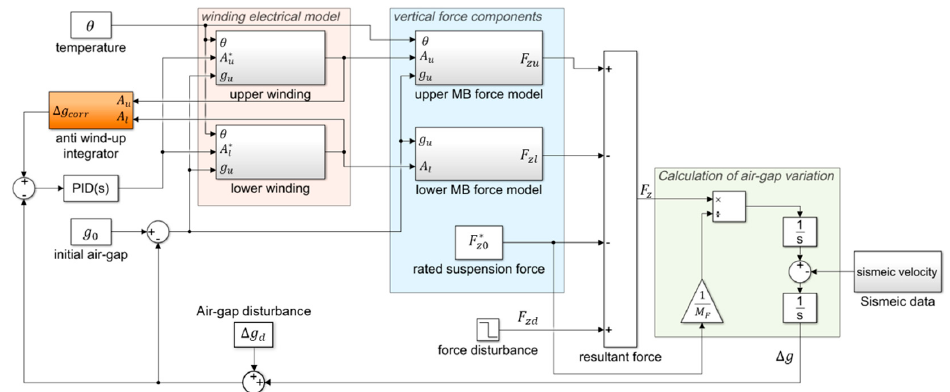
Figure 15. Control scheme of the suspension system.